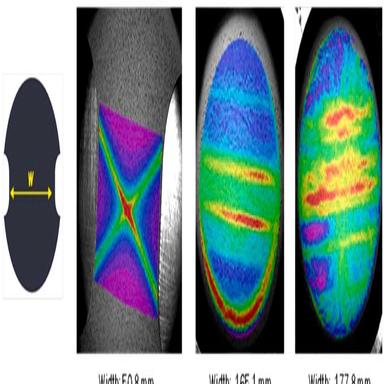
Contours of the major strain prior to fracture for several Marciniak tests. The test specimens for intermediate biaxial stretching exhibited multiple localized necks in the DP1180 steel.